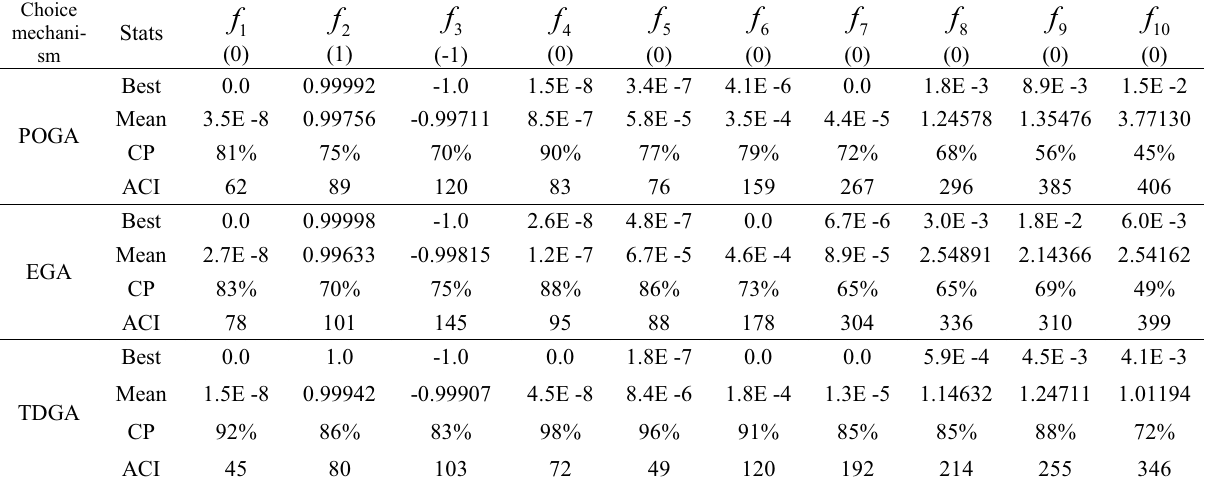
Table 3. Simulation results of different algorithms for f1-f10